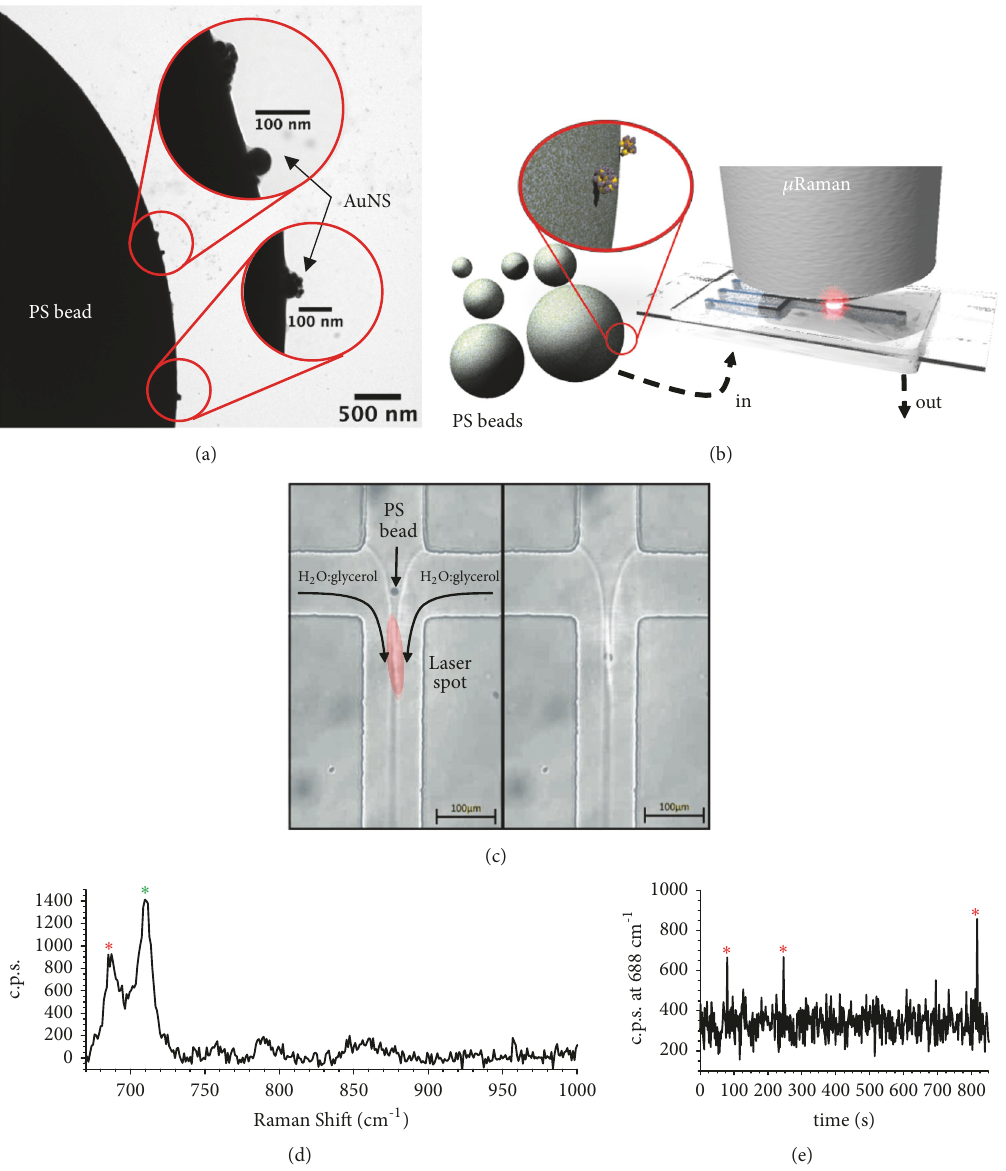
Figure 6: (a) TEM image of a AuNS targeted PS bead, little particles can be observed on the curvature, which are identified as AuNS in the inset magnifications. (b) Sketch of the objective of the 𝜇 -Raman over the microchannel. (c) Optical microscope images of the microfluidic device. A PS bead is caught just before entering on the sampling area (left). The elongated shape of the laser spot allows getting SERS signals from the AuNS-PS bead for a prolonged period (right). (d) Raman spectrum recorded at 815 s, where both the SERS-AuNS signal at 688 cm −1 and the PDMS peak at 710 cm −1 are observed. (e) Signals recorded at the fixed Raman shift of 688 cm −1 during the flowing of the nanoparticles in the